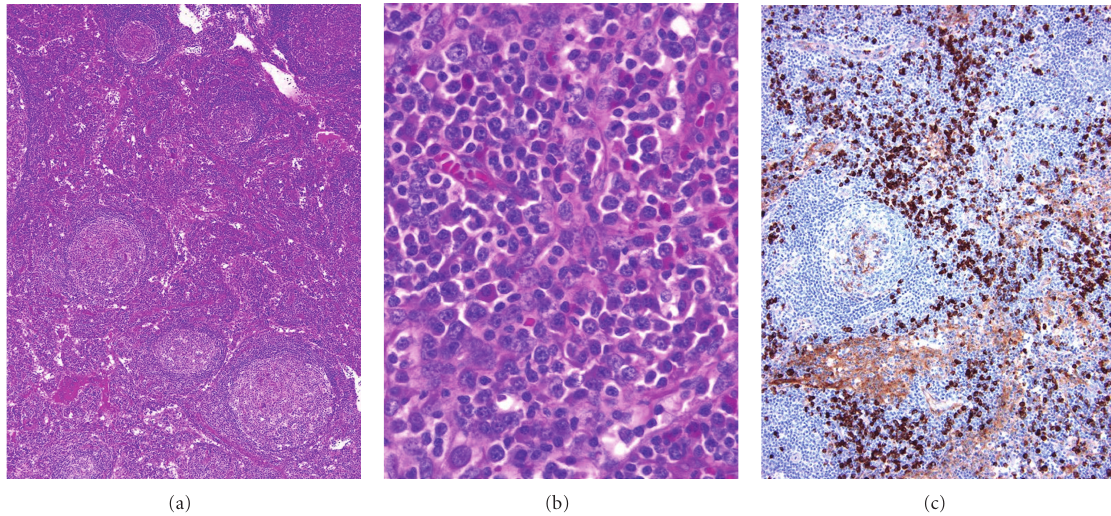
Figure 2: IgG4-related lymphadenopathy (type II). (a) The lymph node shows reactive follicular hyperplasia with intact sinuses. (b) A small to moderate number of mature plasma cells with small lymphocytes and eosinophils are present. (c) Immunostaining shows numerous IgG4 + cells in the interfollicular